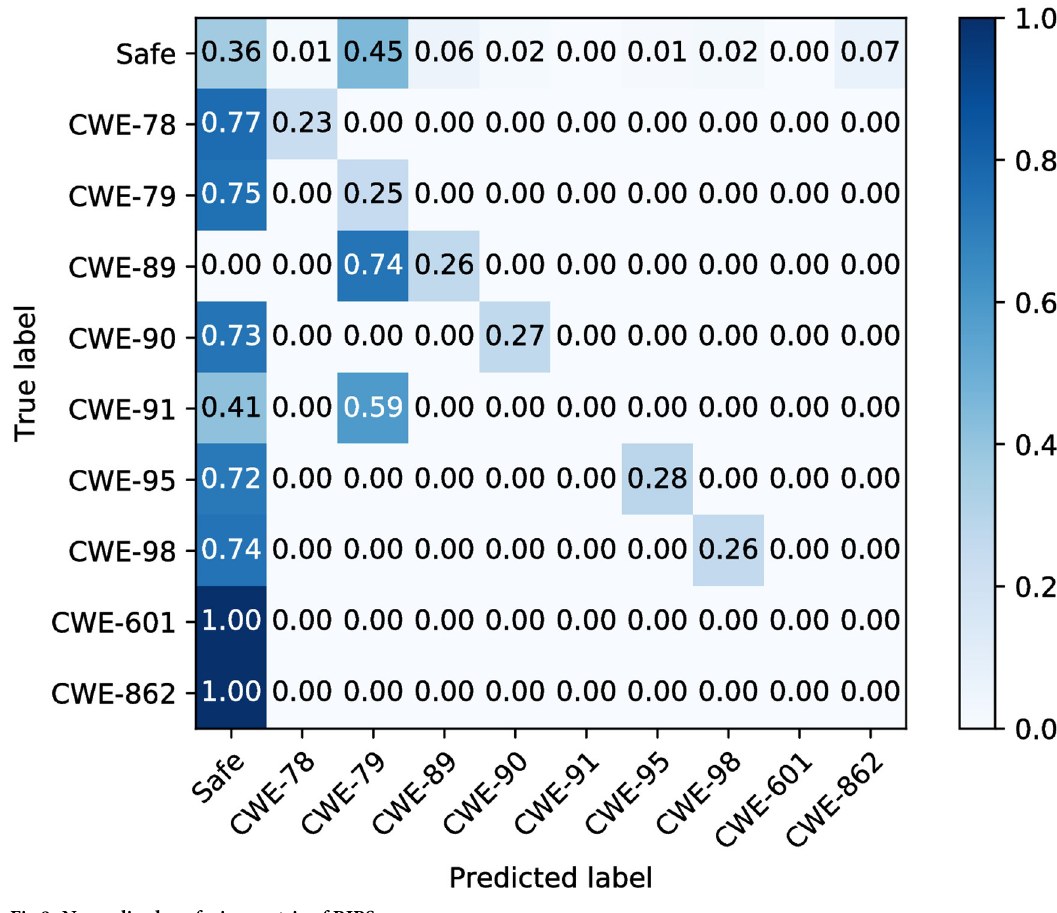
Fig 9. Normalized confusion matrix of